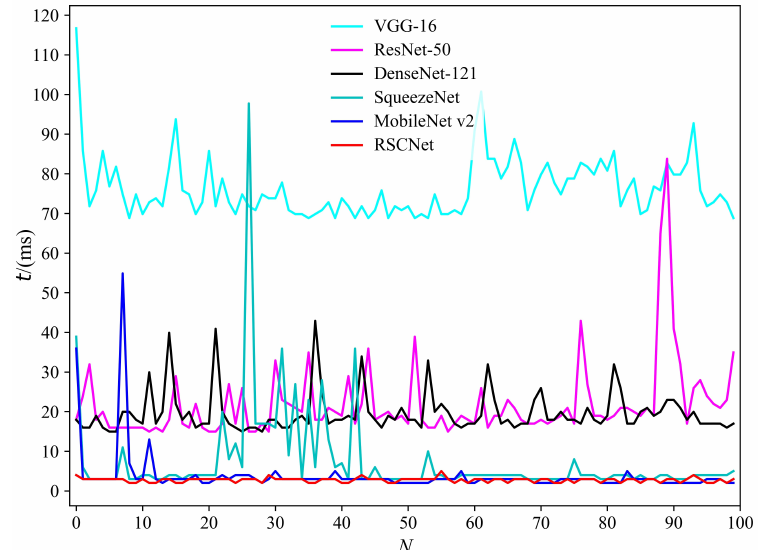
Figure 14. Comparison of inference time for various